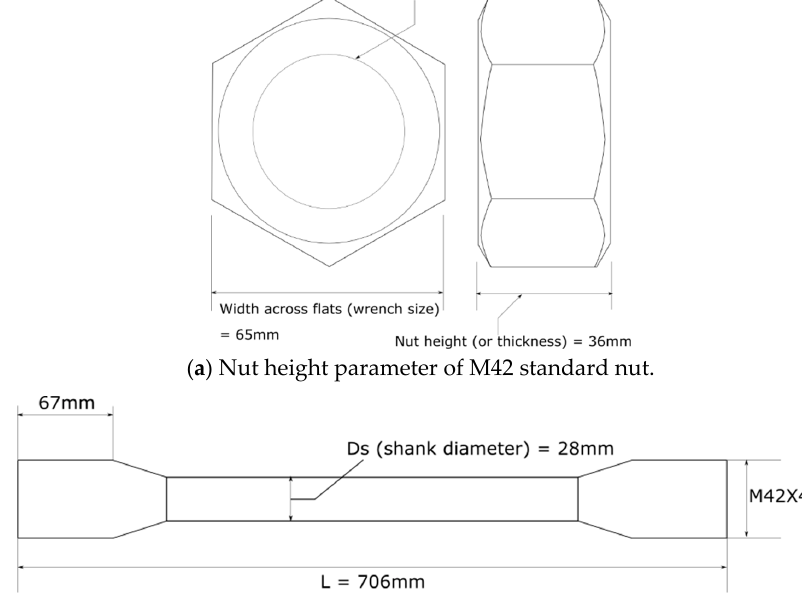
Figure 3. Geometry of nut and bolt.